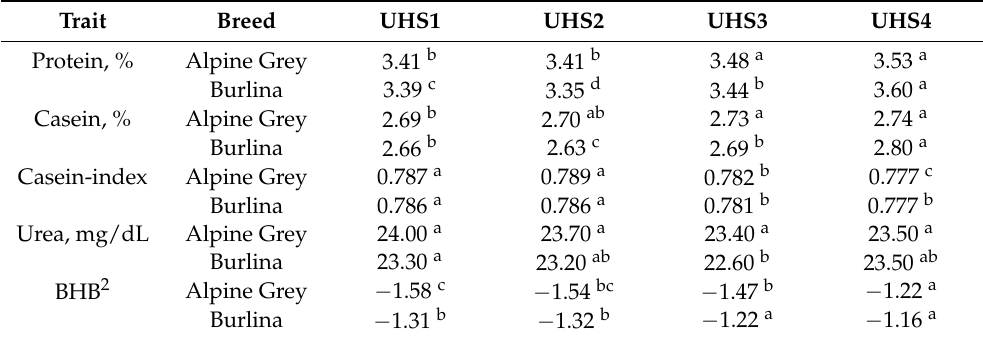
Table 4. Least squares means 1 of protein, casein, casein-index, BHB 2 and milk urea concentration for the interaction between udder health status group 3 and breed. Values with different superscripts within row are significantly different ( p ≤